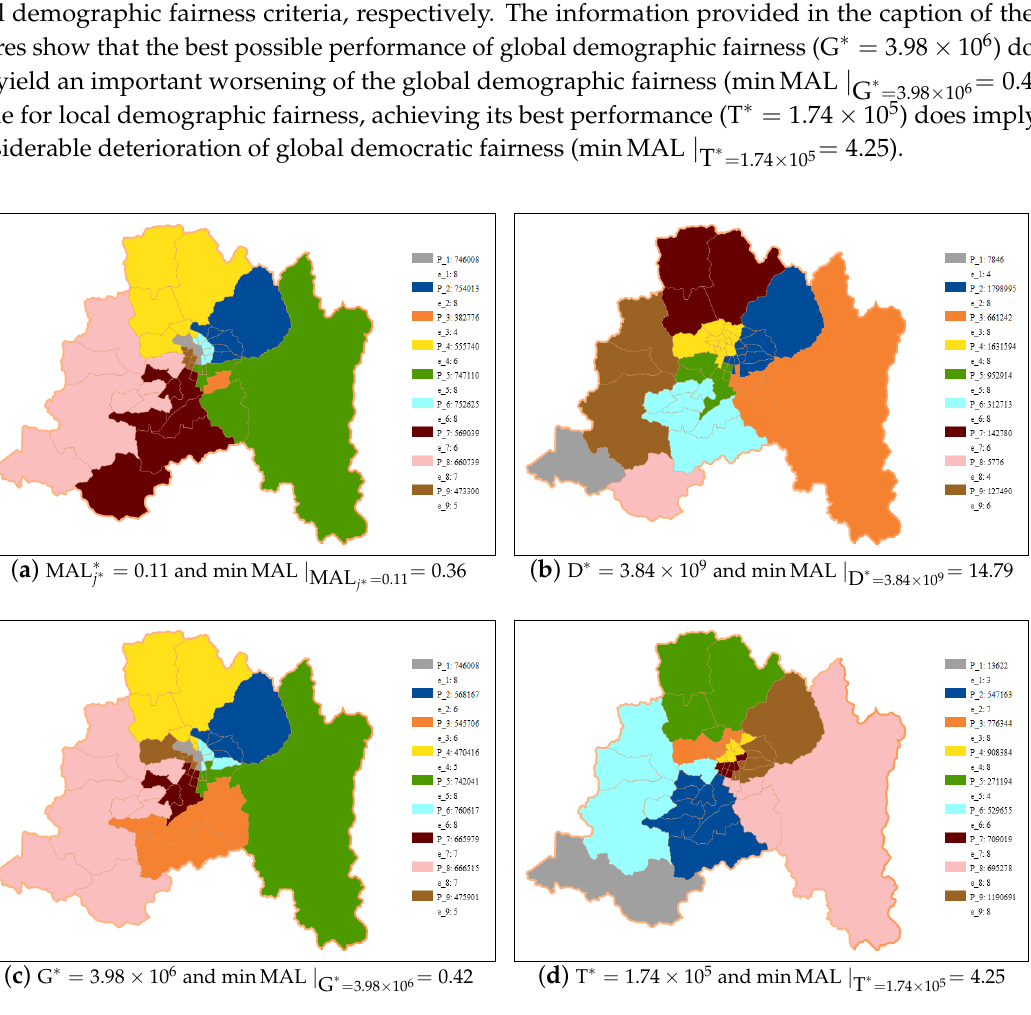
Figure 2. Districting designs for the Metropolitana region: Pursuing the best performance for each